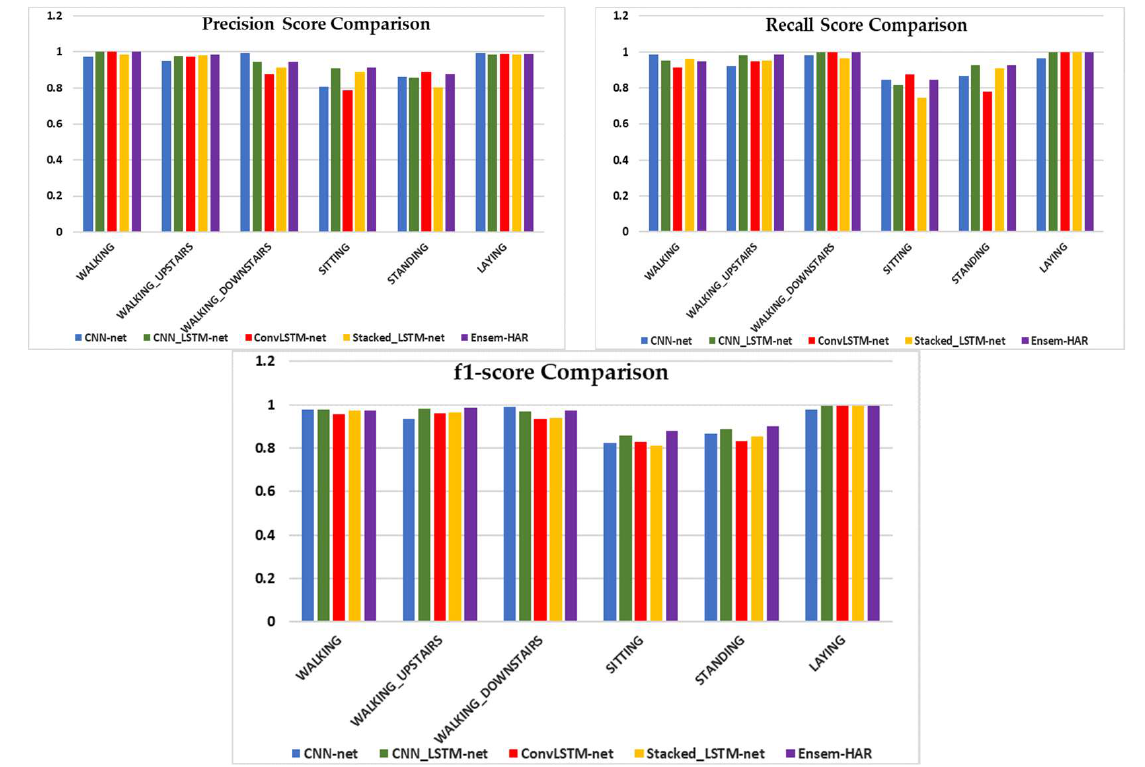
Figure 20. Visual comparison of performance for each activity class in respect of Precision, Recall, and F1-score between ‘CNN-net’, ‘CNN-LSTM-net’, ‘ConvLSTM-net’, ‘StackedLSTM-net’, and ‘Ensem-HAR’ models on the UCI-HAR dataset.